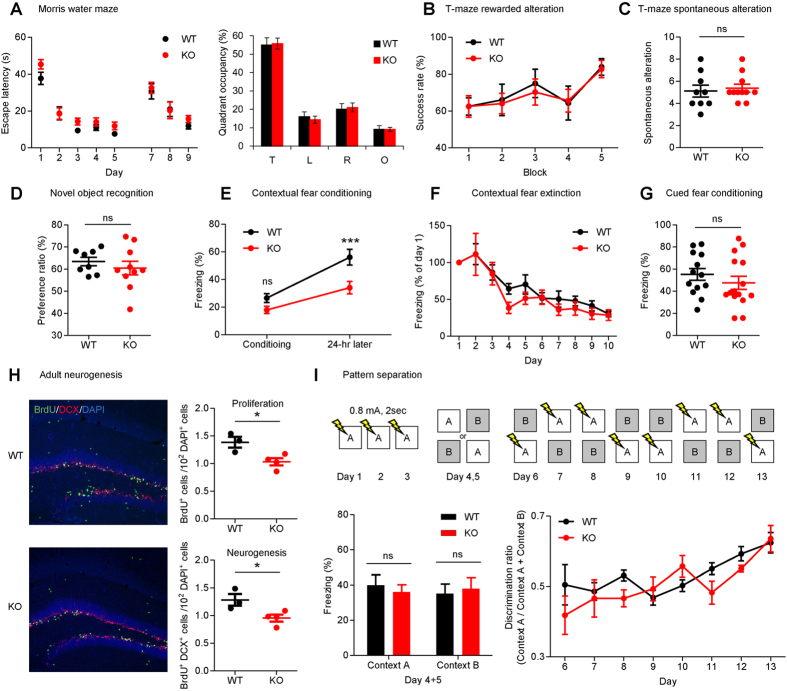
Dorfin−/− mice display a specific deficit in contextual fear memory but not in other types of learning and memory behaviors.(A) Dorfin−/− mice show normal spatial learning and memory in the learning, probe, and reversal phases of the Morris water maze test (T: target, L: left, R: right, O: opposite, s.e.m., n = 14 mice for WT and 16 for KO, ns, not significant, two-way ANOVA, Bonferroni post-hoc, Student’s t-test). (B,C) Dorfin−/− mice display normal spatial working memory in the T-maze rewarded (B) and spontaneous (C) alteration tests (8 trials over 2 days constitutes one block; s.e.m., rewarded, n = 7 for WT and 8 for KO; spontaneous, n = 9 for WT and 11 for KO, ns, not significant, two-way ANOVA, Bonferroni post-hoc, Student’s t-test). (D) Dorfin−/− mice display novel object preference comparable to that of WT mice (s.e.m, n = 8 for WT and 10 for KO, ns, not significant, Student’s t-test). (E–G) Dorfin−/− mice display reduced contextual fear memory but normal fear extinction and cued fear conditioning. (s.e.m., contextual fear conditioning, n = 16 for WT and KO; contextual fear extinction, n = 16 for WT and KO; cued fear conditioning, n = 13 for WT and 15 for KO, ns, not significant, ***p < 0.001, two-way ANOVA, Bonferroni post-hoc, Student’s t-test). (H) Dorfin−/− mice show suppressed neurogenesis in the adult DG. Hippocampal slices from BrdU-injected mice (6 weeks) were triply labeled for BrdU, doublecortin (DCX), and DAPI, and the numbers of BrdU-positive cells as well as cells doubly positive for BrdU and DCX normalized to DAPI-positive cells were quantified. Scale bar, 50 μm. (s.e.m., n = 3 mice for WT and n = 4 for KO, *p < 0.05, Student’s t-test). (I) Normal pattern separation in Dorfin−/− mice. (s.e.m., n = 9 mice for WT and n = 7 for KO, ns, not significant, Student’s t-test, two-way ANOVA, Bonferroni post-hoc).